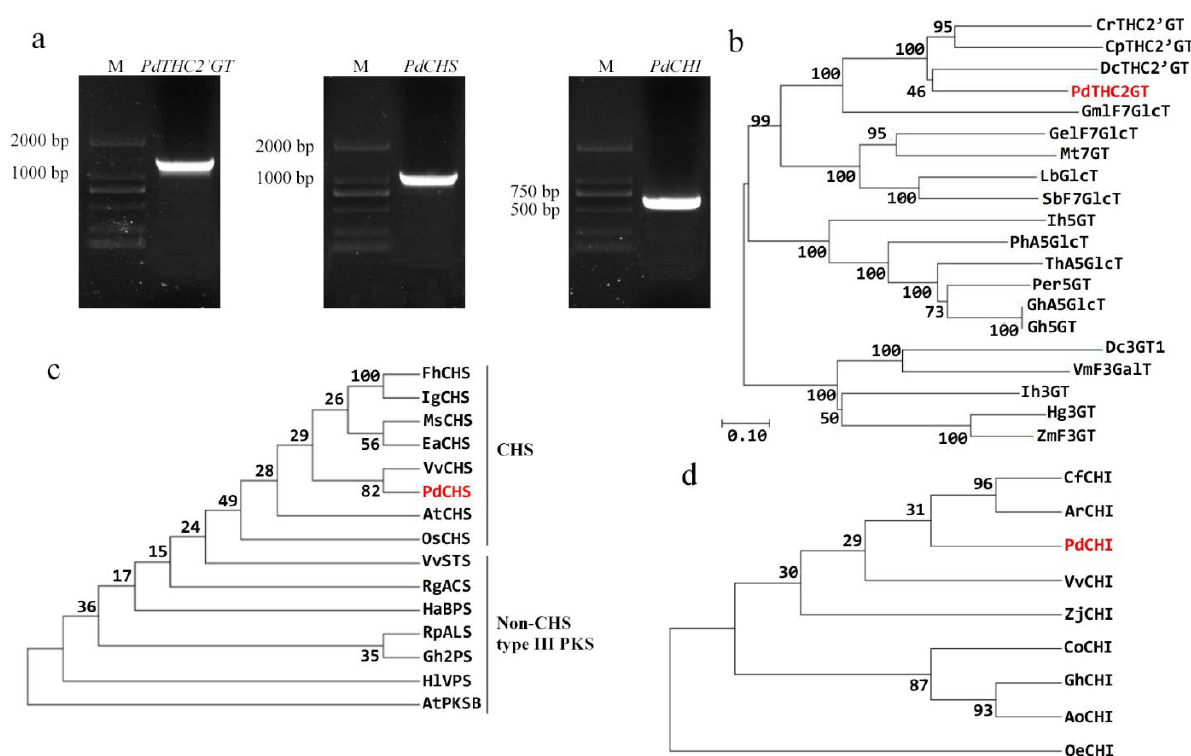
Figure 1. Sequence and phylogenetic analysis. ( a ) Polymerase chain reaction (PCR) amplification products of PdTHC2′GT , PdCHS, and PdCHI . M is DNA marker DL2000. ( b ) Phylogenetic tree analysis of glycosyltransferases. ( c ) Phylogenetic tree analysis of chalcone synthase. ( d ) Phylogenetic tree analysis of chalcone isomerase. The protein sequences are listed in Table S2. Red font is the gene of P. delavayi var. lutea .